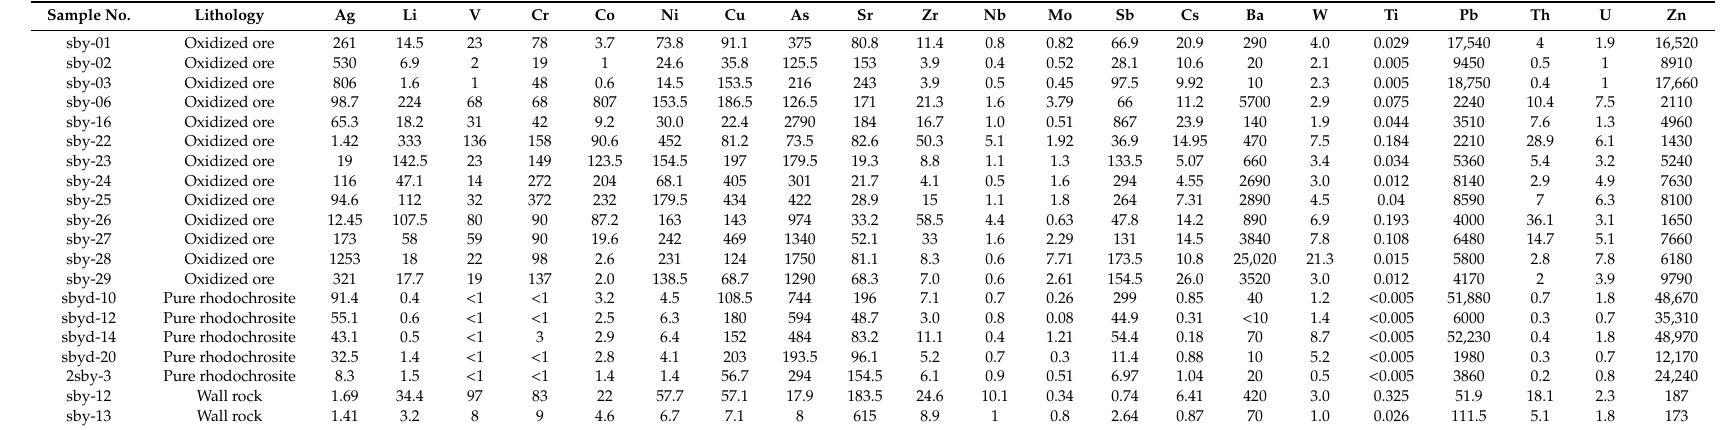
Table 4. Silver and trace element contents (ppm) of the oxidized ores, primary ores (pure rhodochrosite), and wall rocks from the Sanbao deposit. Sample